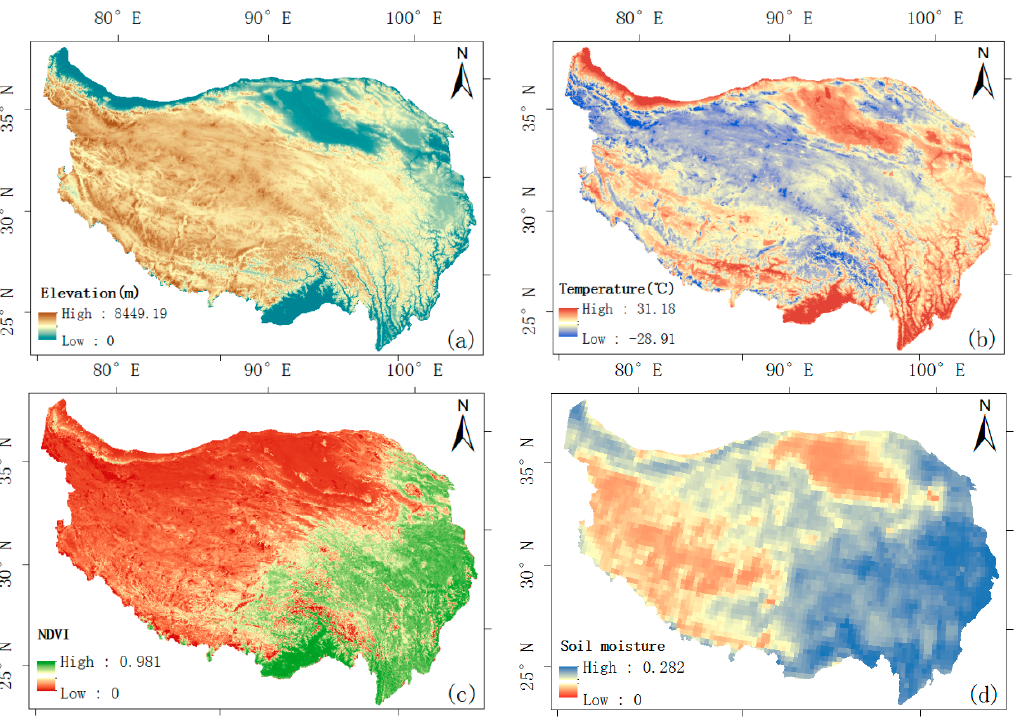
Figure 2. ( a ) Elevation of the Qinghai-Tibet Plateau; ( b ) The mean average surface temperature of 2003; ( c ) NDVI maximum in 2003; ( d ) Average soil moisture in May 2003.